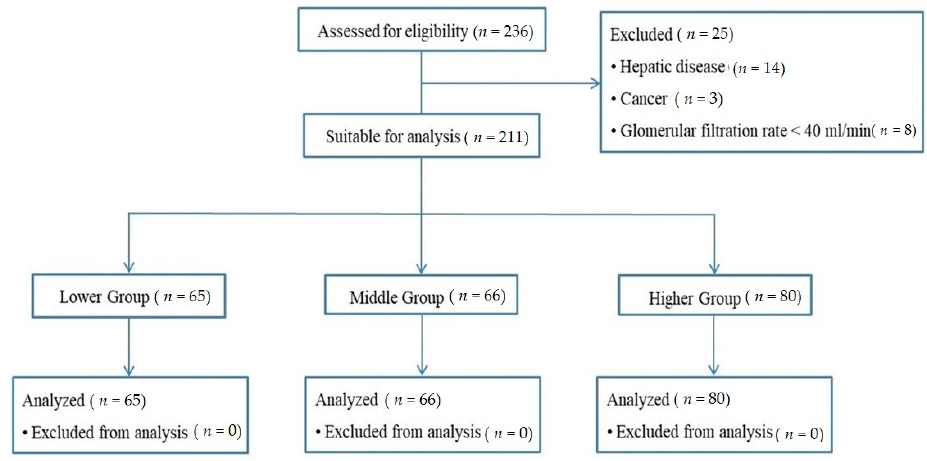
Figure 1. Consort flow diagram. Table 1. Demographic data according to the level of ALP.